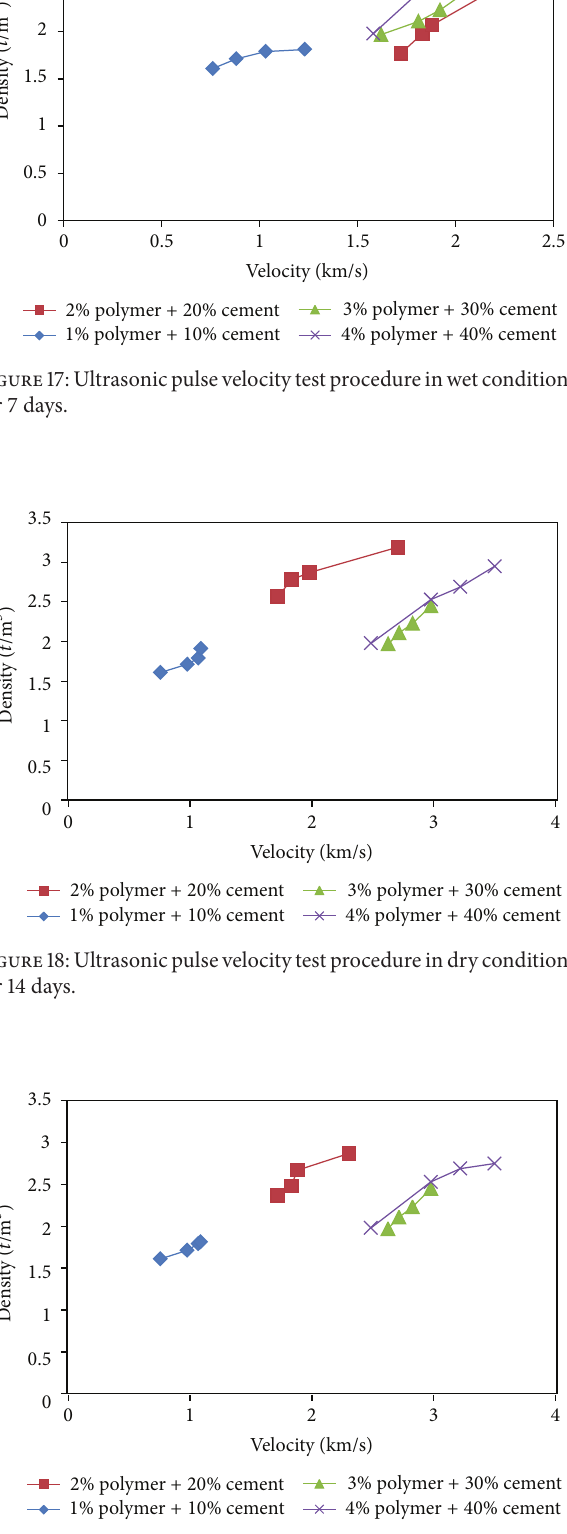
Figure16:Ultrasonicpulsevelocitytestprocedureindryconditions for 7 days.